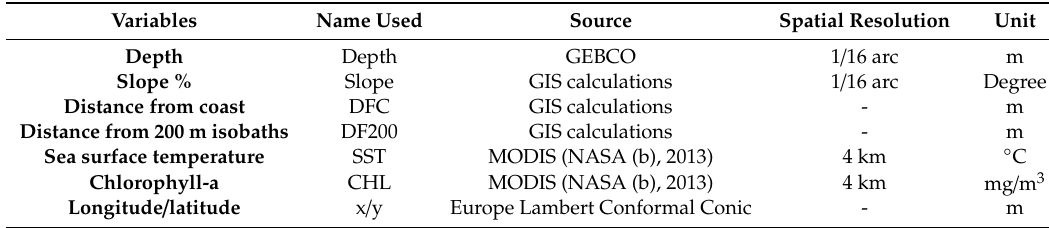
Table 1. Characteristics of the variables used in spatial